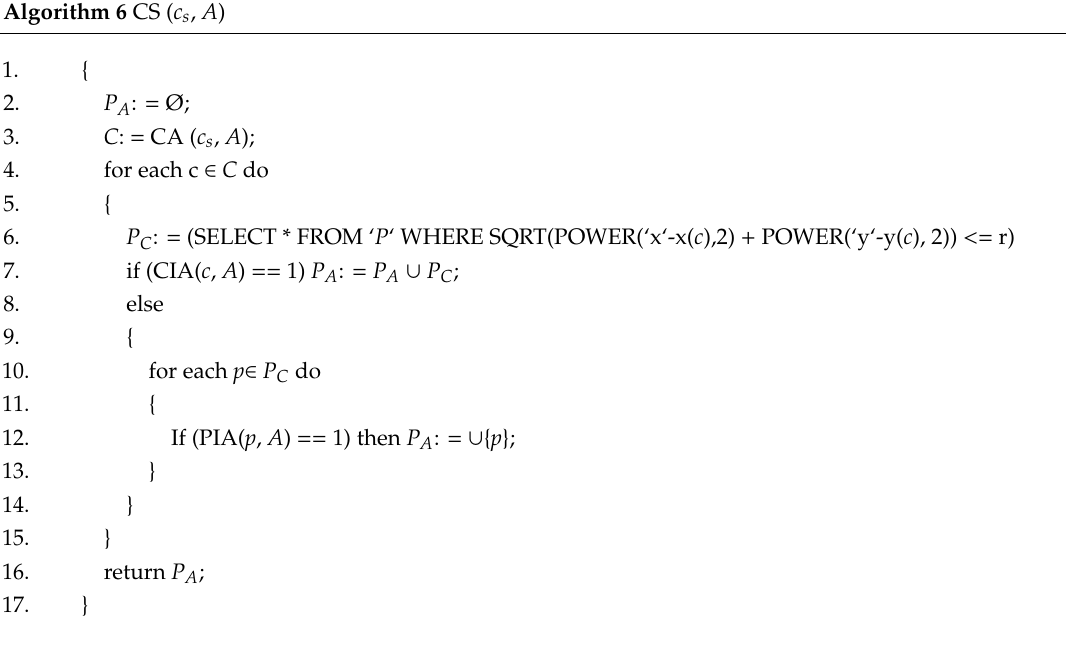
Algorithm 6 CS ( c s , A